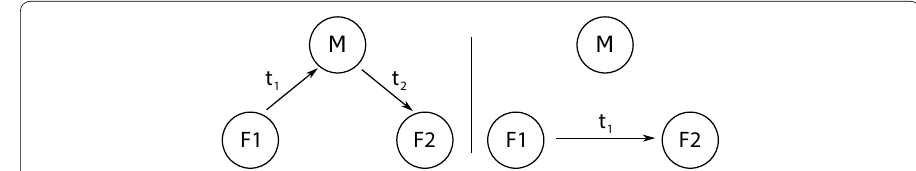
Fig. 2 An example of a sequence of two movements in the complete network summarised by a single movement in the reconstructed